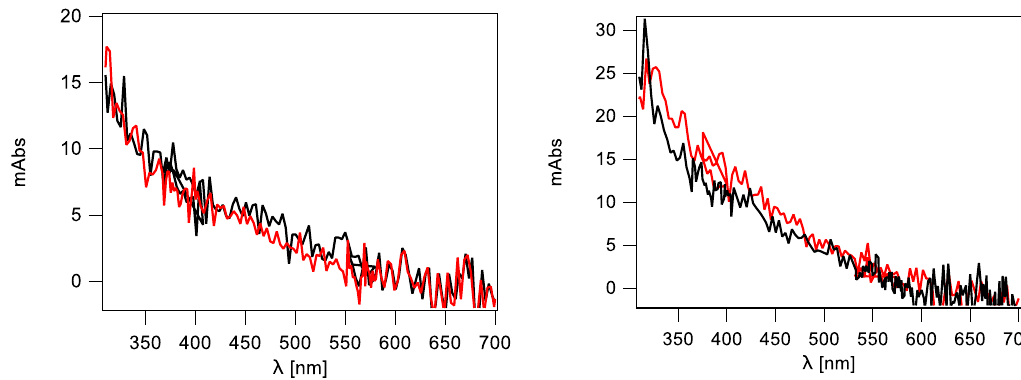
Figure 7. Transient absorption spectra recorded using ICCD in N 2 O-saturated phosphate bu ff ered (50 mM) aqueous solutions containing (left panel) ds-(ODN1 / ODN2) and (right panel) ds-(ODN3 / ODN4) at natural pH: ( − ) 1 µ s and ( − ) 50 µ s after electron pulse.